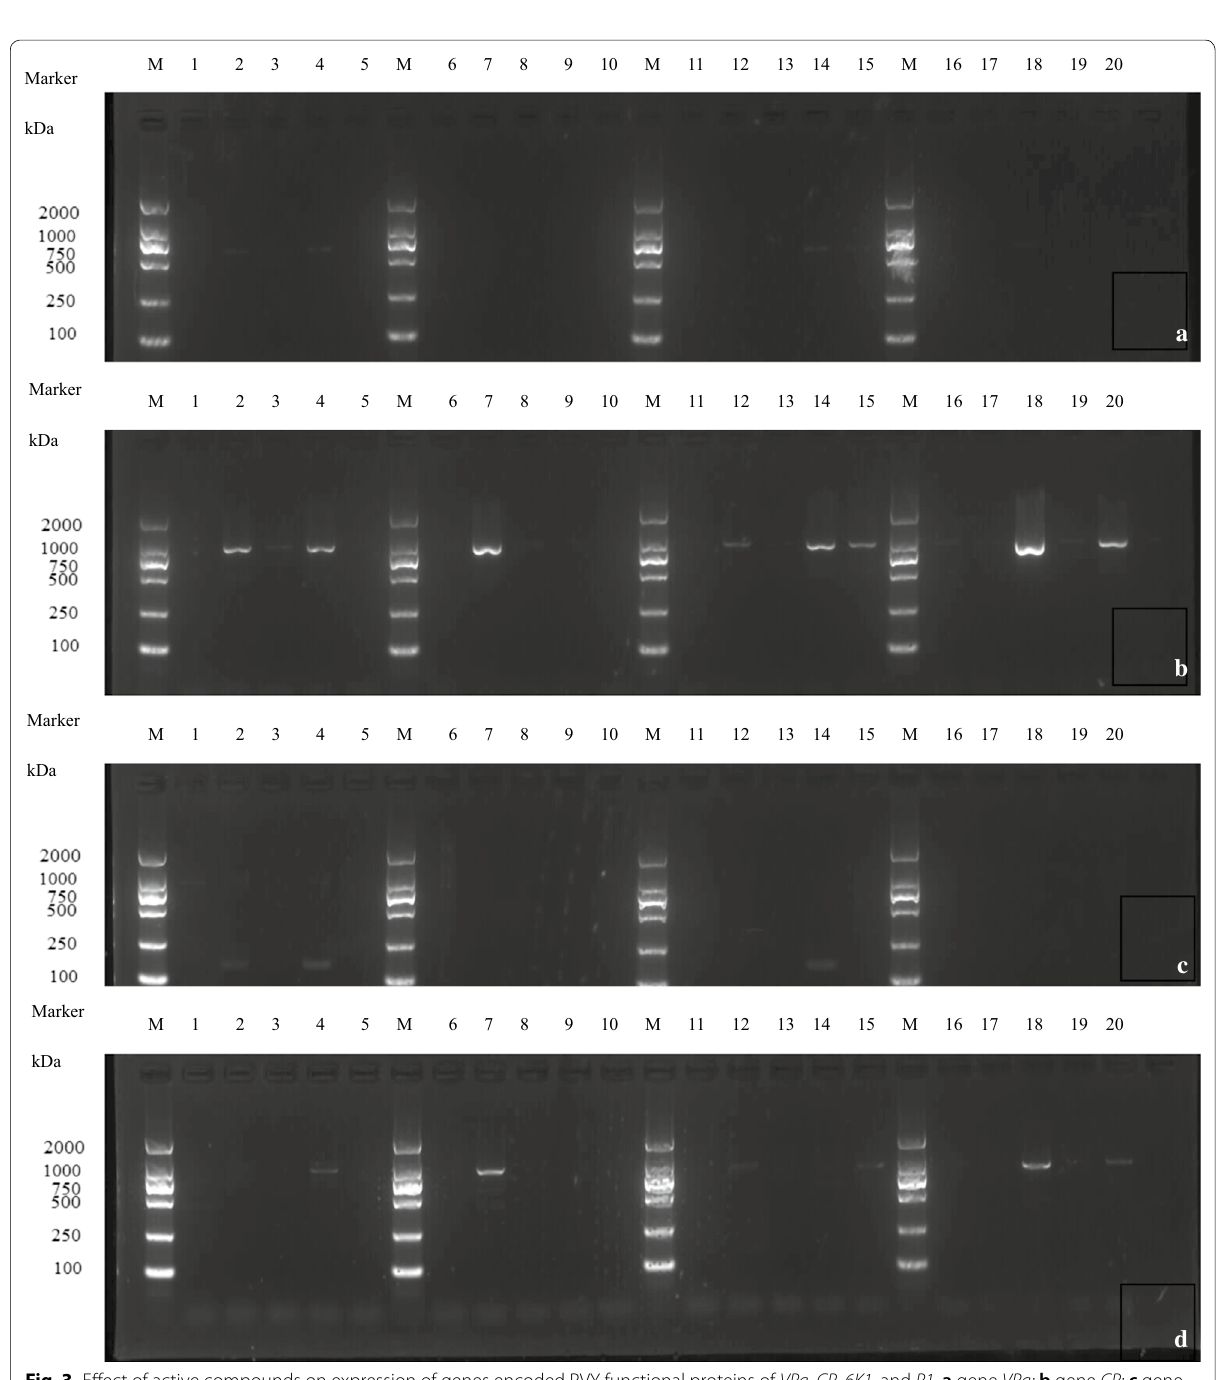
Fig. 3 Effect of active compounds on expression of genes encoded PVY functional proteins of VPg , CP , 6K1 , and P1 . a gene VPg; b gene CP; c gene 6K1; d gene P1. M: Marker lane; Series of Lanes 1–5: compound 5 ; 6–10: compound 1; 11–15: compound 9 ; 16–20: compound 4. Each series of 5 lanes between markers represents the concentrations used: 500, 250, 125, 63, and 31 μg/mL, from left to